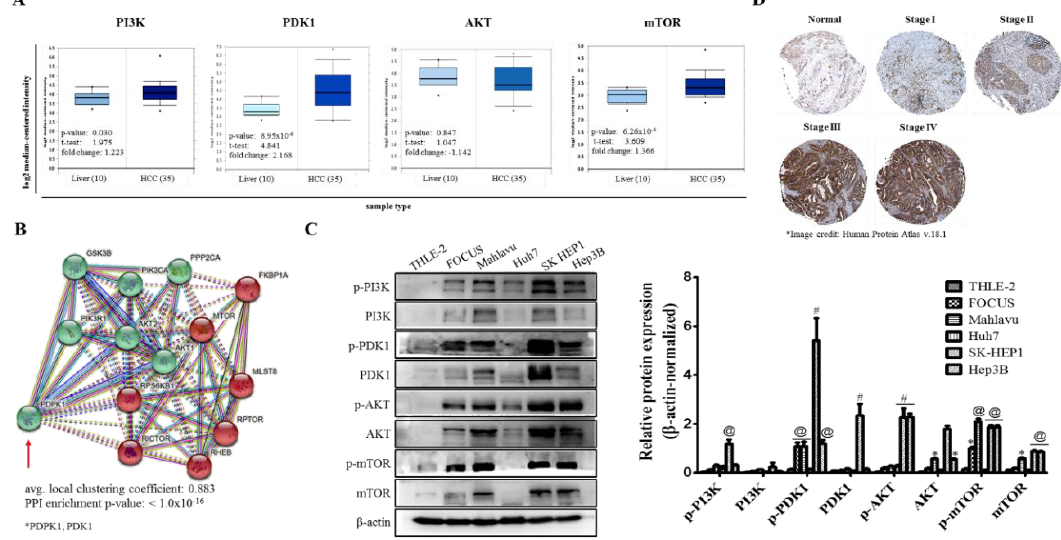
Figure 1. PDK1 is an independent driver of the PI3K/AKT/mTOR signaling pathway and its aberrant expression characterizes poorly differentiated aggressive hepatocellular carcinoma (HCC) cells. ( A ) Box and whisker plots of the differential expression of PI3K, PDK1, AKT and mTOR in HCC or normal liver tissues from the Wurmbach liver cohort. ( B ) STRINGdb-generated visualization of the protein – protein interaction between PDK1/PDPK1, and molecular components of the PI3K/AKT/mTOR signaling pathway. ( C ) Representative Western blot images and histograms showing the differential expression of p-PI3K p85 (Tyr458)/p55 (Tyr199), PI3K, p-PDK1 (Ser 241), PDK1, p-AKT (Ser 473), AKT, p-mTOR (Ser 2448) and mTOR proteins in THLE-2, CVCL_7955, Mahlavu, Huh7, SK-HEP1 or Hep3B cell lines. ( D ) Representative IHC images of PDK1 immunoreactivity in Stages I – IV HCC, compared to normal liver tissue. β -actin served as loading control. * p < 0.05, @ p < 0.01, # p < 0.001 vs. THLE-2; Green nodes, PI3K/AKT signaling; red nodes, mTOR signaling; PPI, protein – protein interaction.